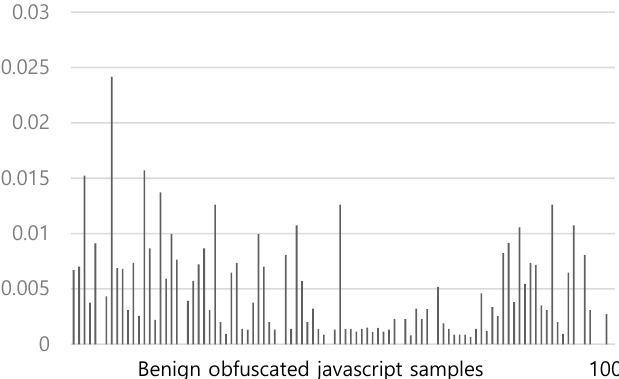
Figure 9. TF-IDF average values over redirection tokens in 100 obfuscated benign JavaScripts using the revised TF-IDF.